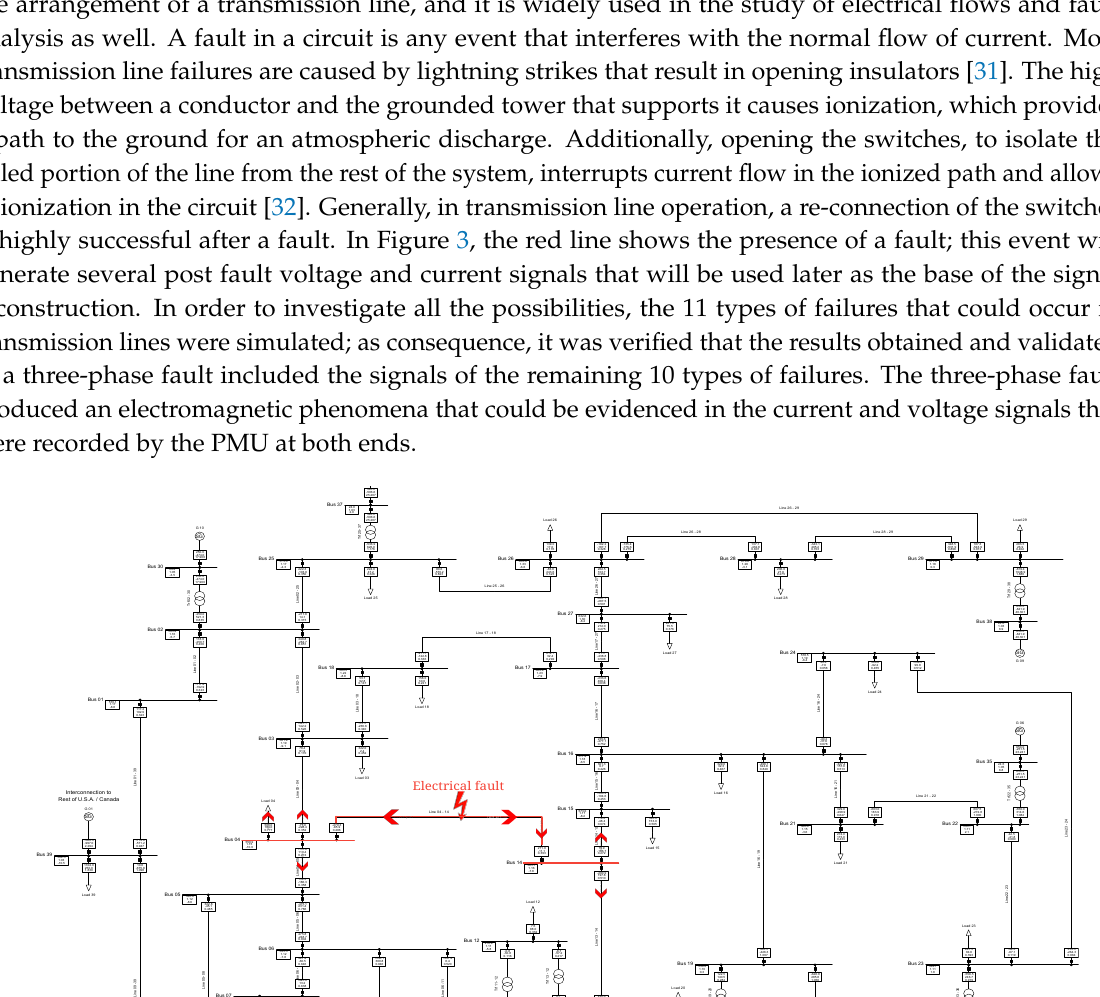
DIgSILENT GmbH PowerFactory 15.1.7